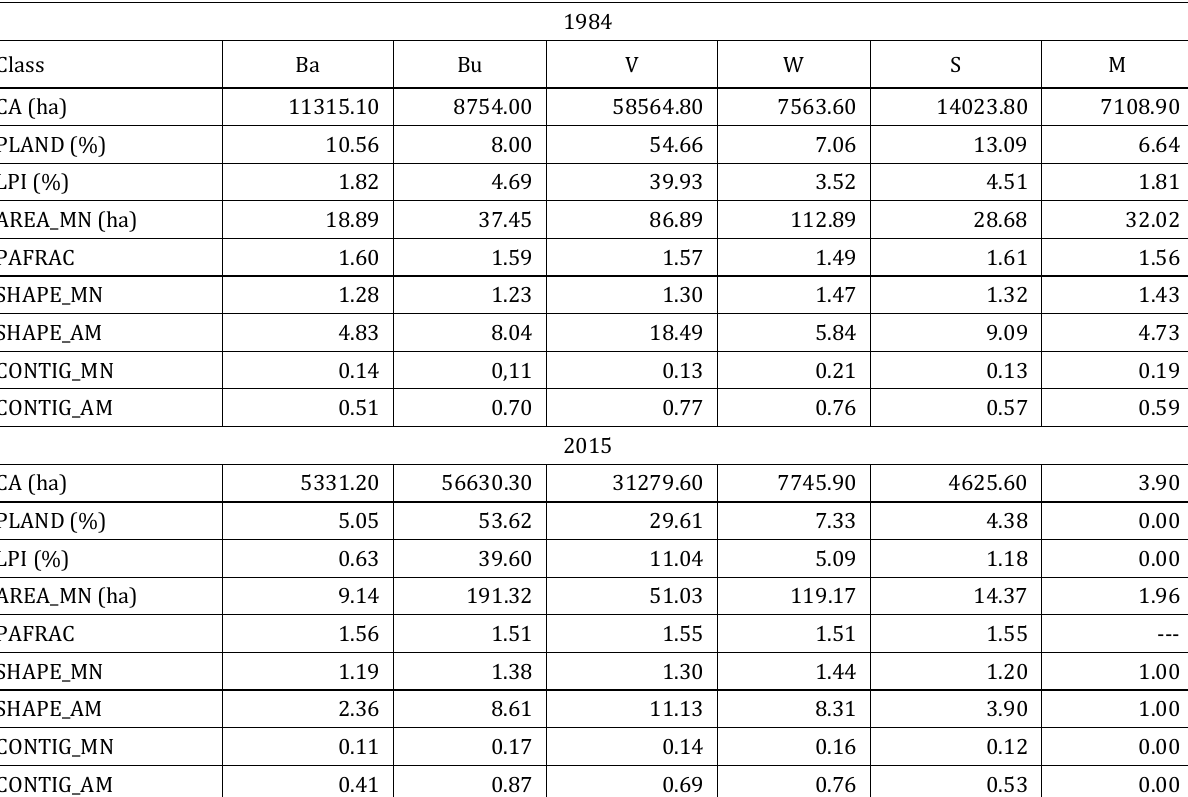
Table 3. Class level metrics – 1984 and